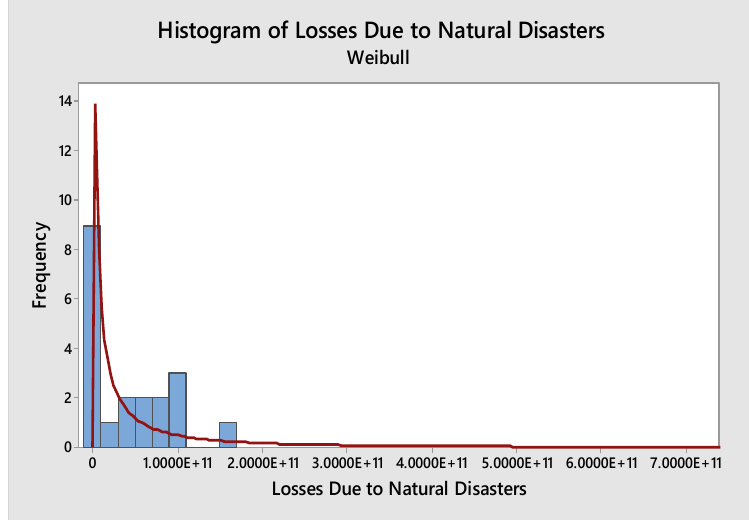
Fig. 3 . Histogram of Data Losses Due to Natural Disasters in Indonesia